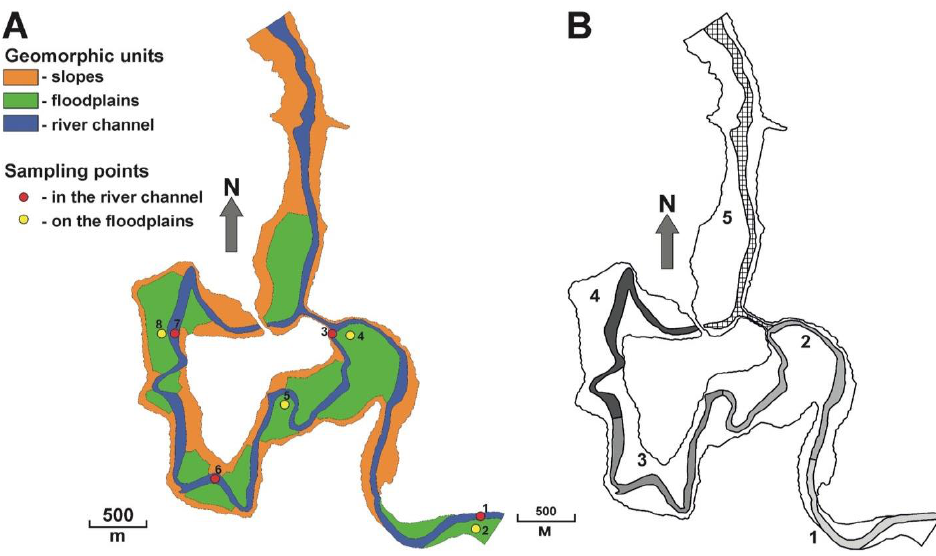
Figure 10. ( A ) Geomorphic structure of Schekino Reservoir bottom with locations of sampling points; ( B ) locations of sections (marked with numbers 1–5) arranged for calculations for river channel to assess accumulation for post-Chernobyl period.